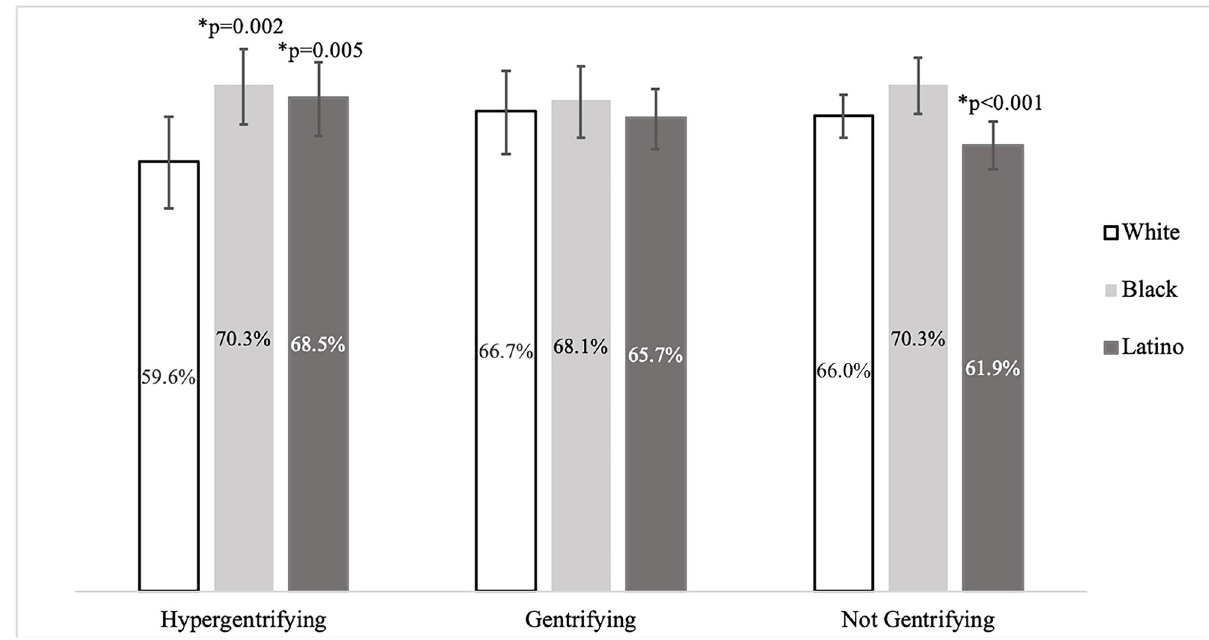
Fig 4. Hypergentrifying neighborhoods have a higher percentage of Black and Latino people lived in their house for � 5 years compared with White people. Percentage of residents who have lived in their homes for � 5 years stratified by level of gentrification and race/ethnicity in New York City, 2017. Data from the New York City Community Health